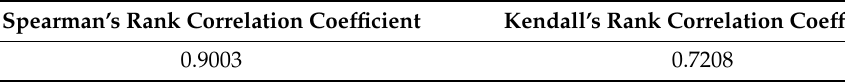
Table 1. Correlation coefficient between CLEVER score and defense success